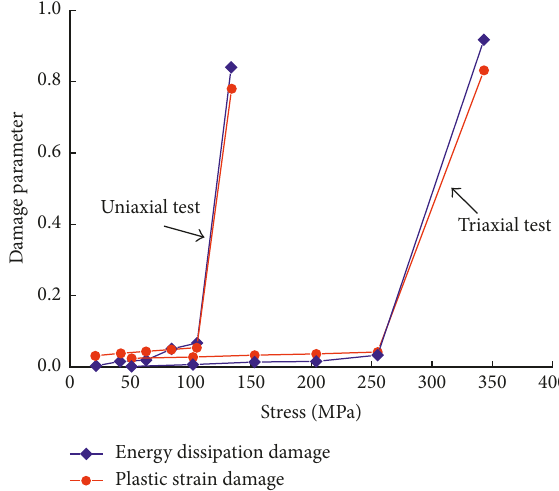
Figure 13: Comparison of two damage parameters under cyclic loading.